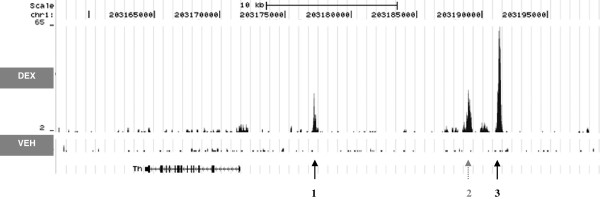
Genomic distribution of Glucocorticoid Receptor binding sites (GBS) upstream of the Tyrosine Hydroxylase gene (TH). Two significant peaks representing GR-binding are observed at approximately 5.7 kb (peak 1) and 19.7 kb (peak 3) upstream of the transcription start site (TSS) as indicated by arrows. The 5.7 kb GBS was previously described in PC12 cells transfected with the TH promoter [34]. A third peak (peak 2) upstream of the TH gene was apparent, but was not significantly above background (IgG signal) at this position, so was not further analysed. Data was visualized with the UCSC genome browser [35].